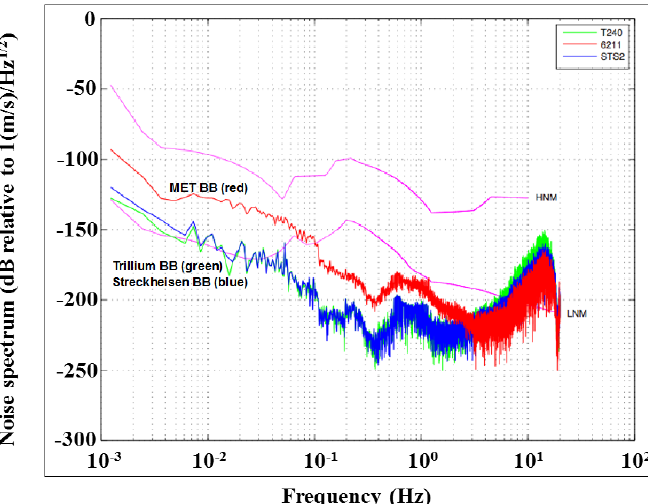
Figure 3. Noise performance of a MET seismometer (CME-6211) in comparison with high-performance, industry-grade broadband seismometers. Red: MET seismometer CME-6211; Blue: Streckheisen STS-2 broadband seismometer; Green: Trillium T240 broadband